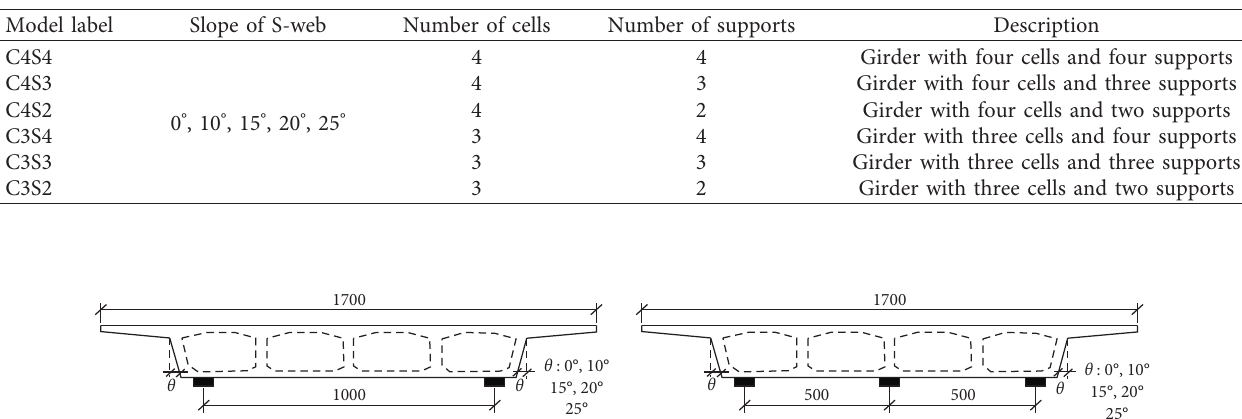
Figure 1: Basic box-girder model and rotation of the side web (unit: Table 1: Model parameters.